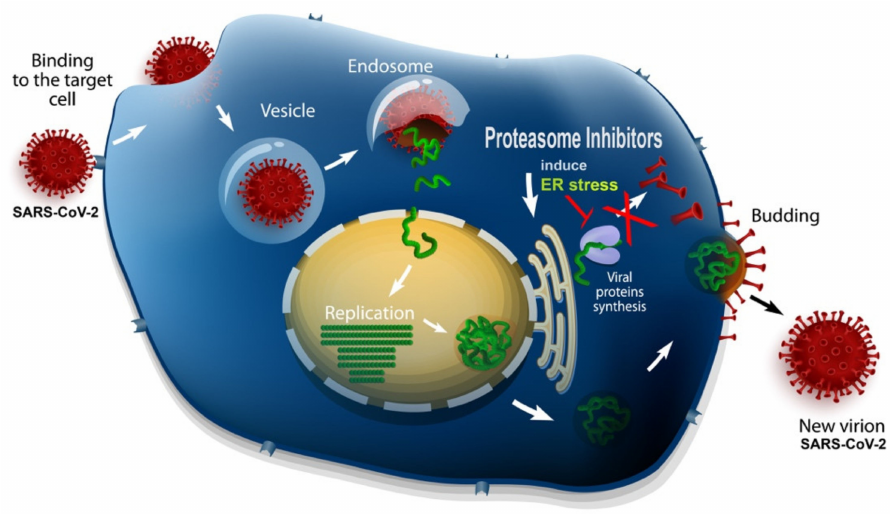
Figure 3. A schematic representation of the possible mechanism of proteasome inhibitors in virus